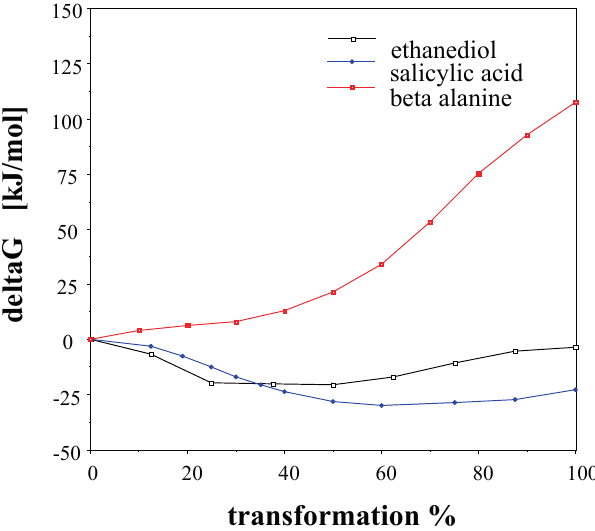
Figure 4. The free energy perturbation (FEP) curves for the transformations of conformers with an intramolecular H-bond to structures without H-bonds. Shown are 1,2-ethanediol ( 1 ) to ( 2 ), salicylic acid ( 3 ) to ( 4 ), and β -alanine zwitterion ( 5 ) to ( 6 ) where structure numbering is taken from Figure